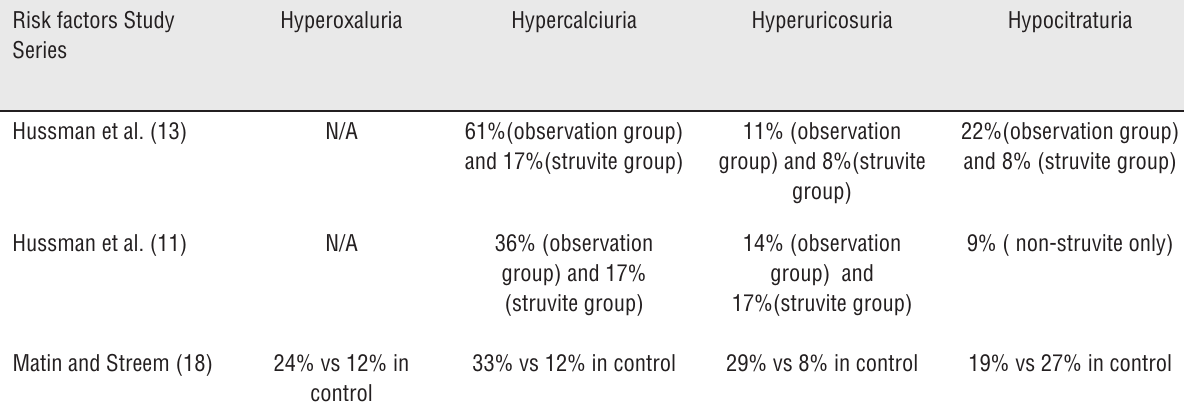
Table 1 - Metabolic risk factors for stone formation in patients with PUJO (percentages correspond to those that were metabolically